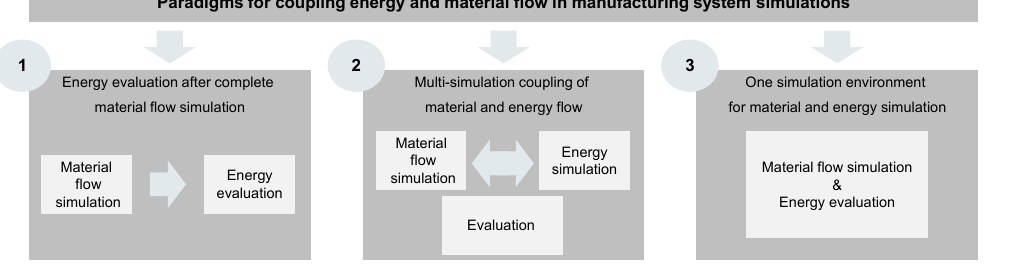
Figure 2. Paradigms for coupling energy and material flow in manufacturing system simulations (own illustration based on Herrmann et al. [25]).